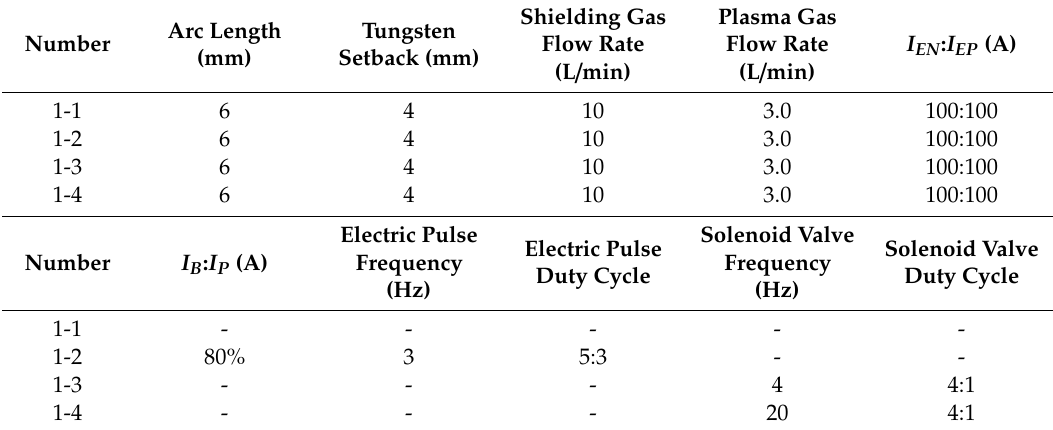
Table 1. Parameters for arc image and electrical signal comparison.